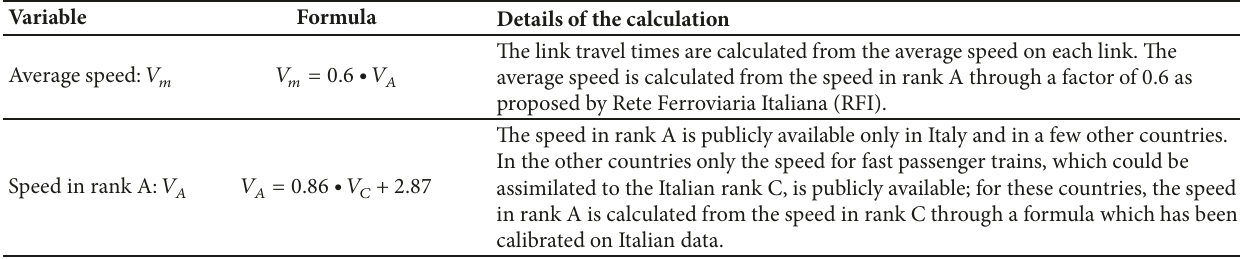
Table 2: Summary of the procedure adopted in this paper for the calculation of link travel